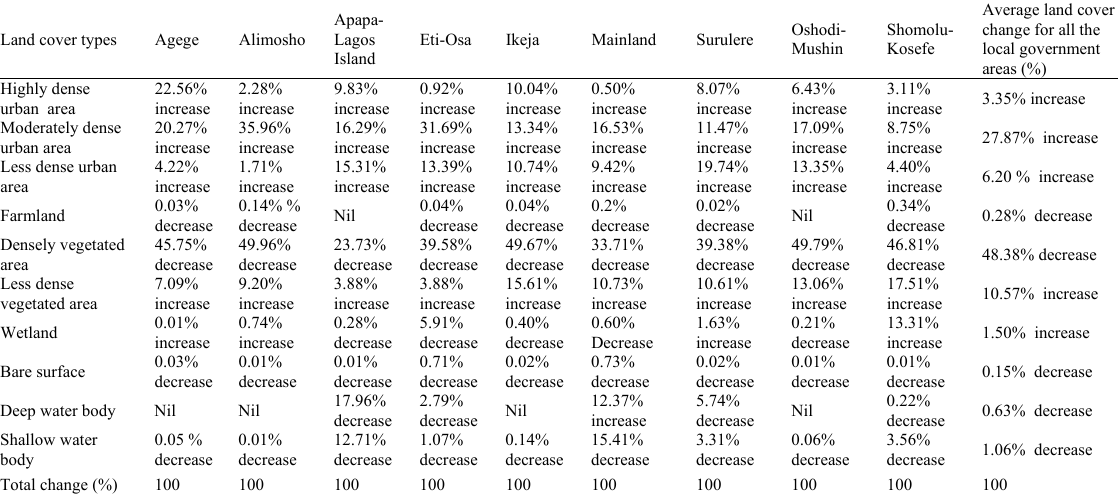
Table 2: Change detection for the various land cover types between 2002 and 2013 (in %)